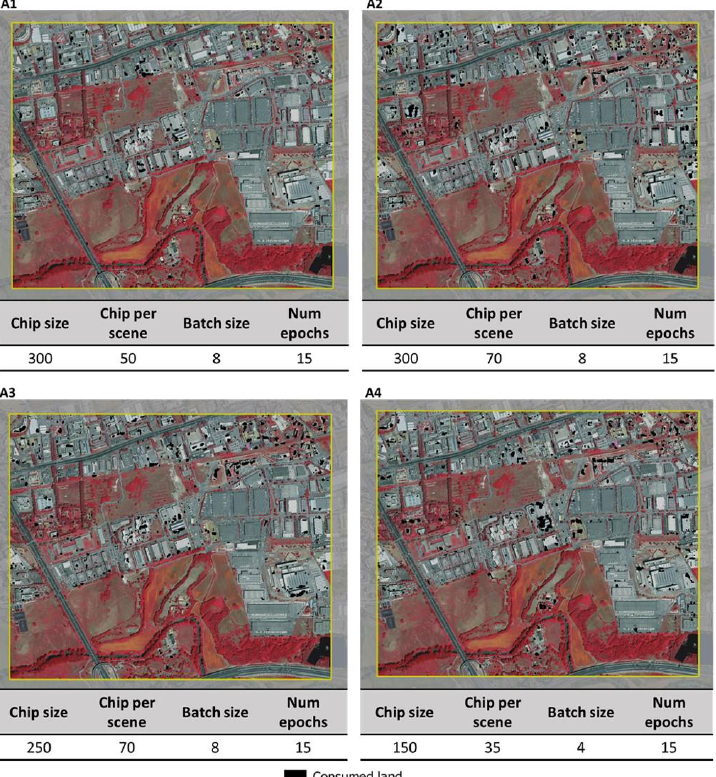
Figure 5. Classification examples relating to the first scenario, with reference to 4 distinct experiments.